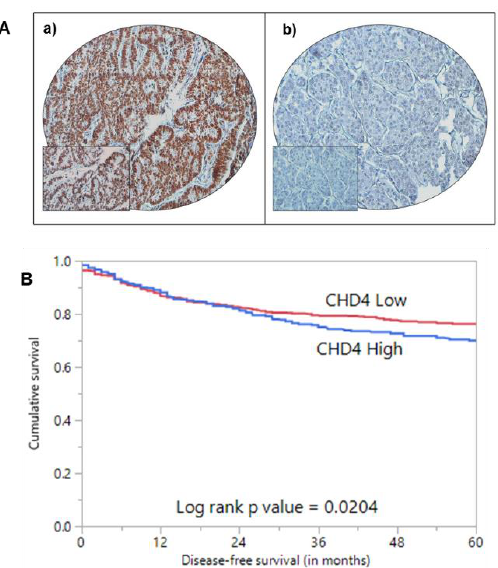
Figure 1. Immunohistochemical and survival analysis of CHD4 expression in Papillary Thyroid Cancer (PTC) TMA. ( A ) Representative examples of tumors showing (a) high expression and (b) low expression (right panel) of CHD4. (20×/0.70 objective on an Olympus BX 51 microscope. (Olympus America Inc., Center Valley, PA, USA) with the inset showing a 40